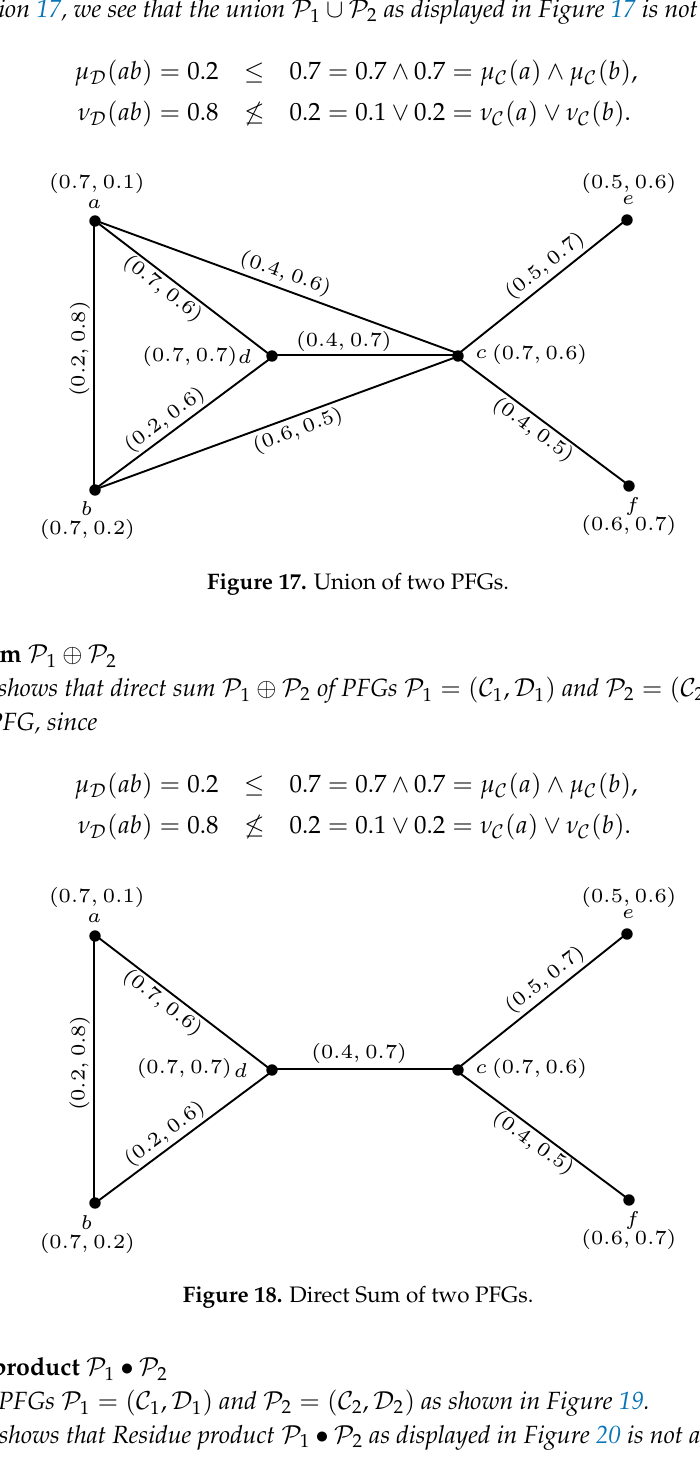
Figure 4.3: Direct Sum of two PFGs.